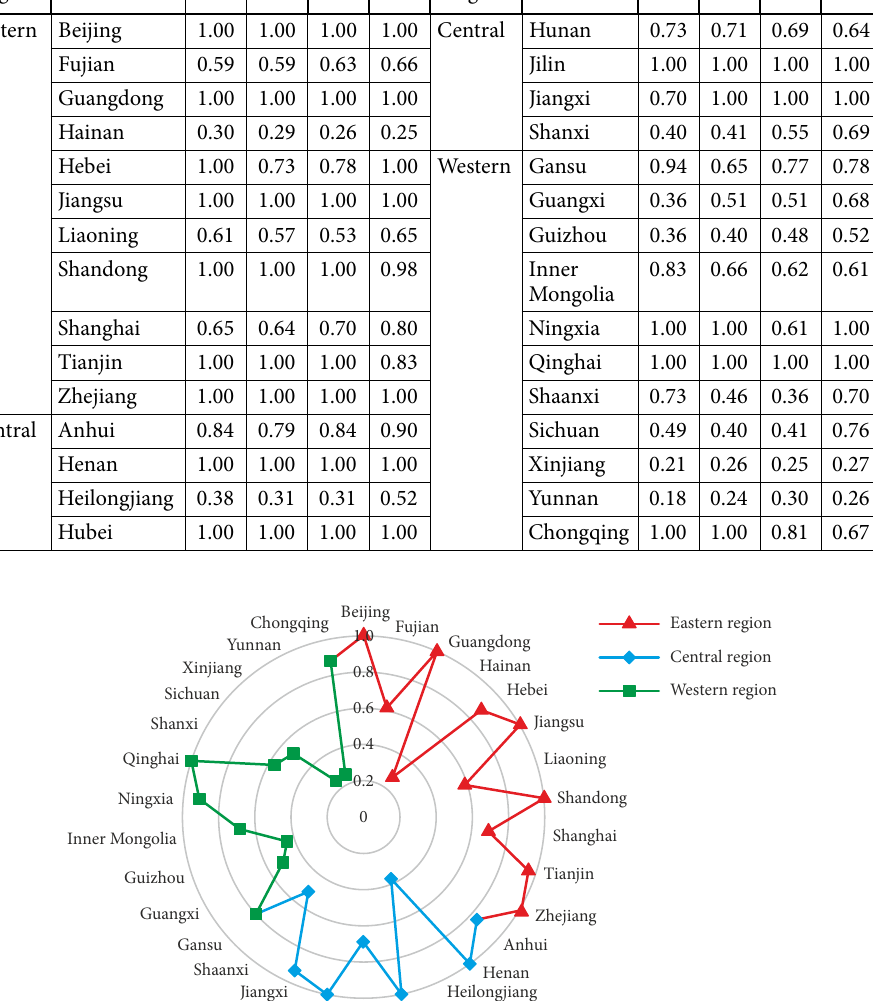
Table 8. Application stage efficiency from 2015 to 2018 Region